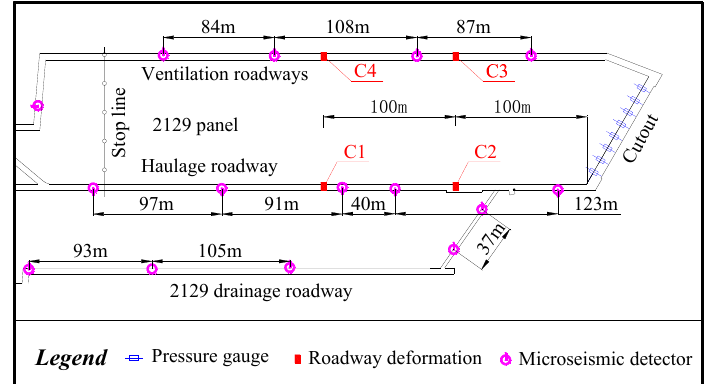
Figure 7. Layout of the monitoring stations.